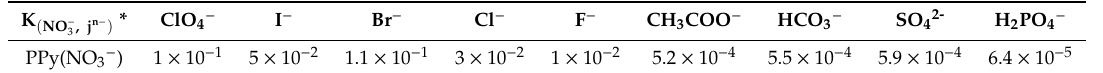
Figure 5. ISE Performance comparisons between two tested mediate layers of ERGO / AuNPs and ERGO ( a ) cyclic voltammetries (CVs); ( b ) EISs; ( c ) OCPT; ( d ) stability; ( e ) response time; ( f ) lifetime of the ISE with the composite mediate film (Supplementary Materials S2). Table 2. The selectivity coe ffi